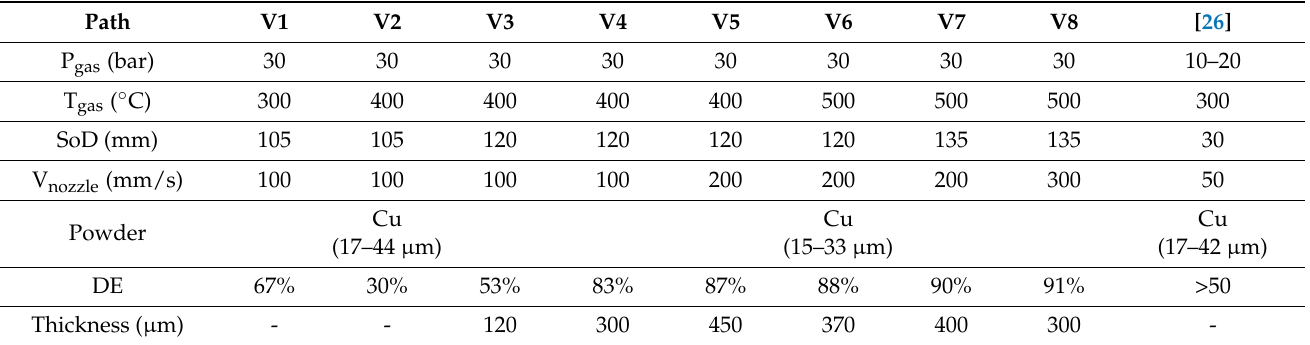
Table 1. Optimization process for reaching the DE of 91% during the HPCS metallization of PEEK, and coating thickness in µ